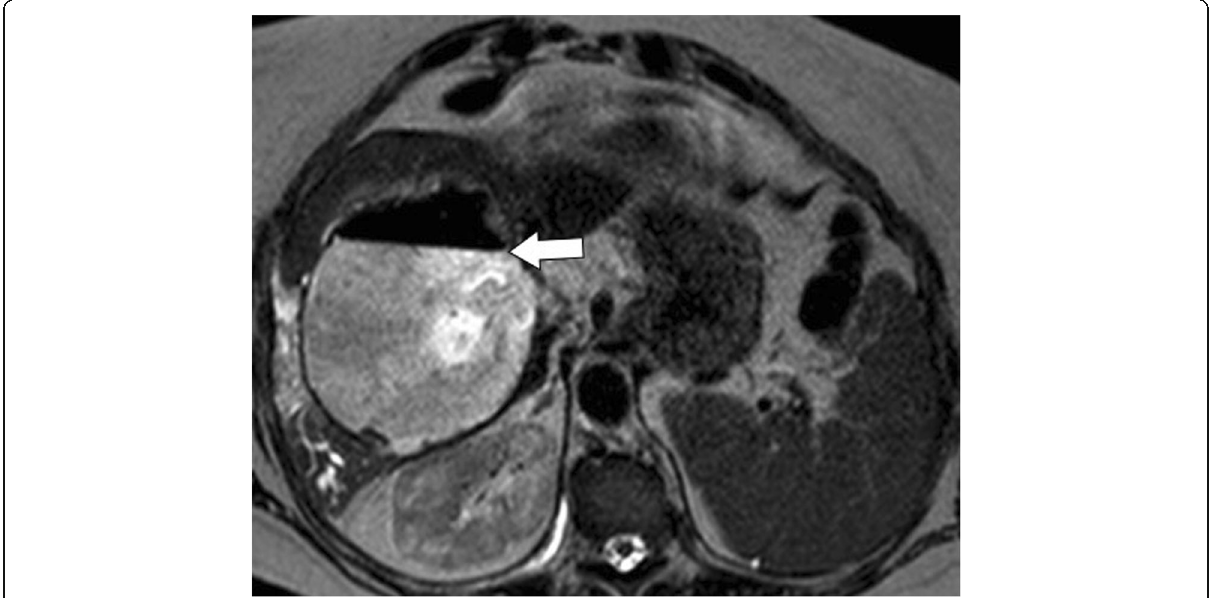
Fig. 13 A 66-year-old woman with infected hydatid cyst. Axial T2-weighted MR image demonstrates an air-fluid level (arrow) within a calcified hydatid cyst, but lack of frank cysto-biliary communication. This finding suggests superinfection of a ruptured hydatid cyst that was later